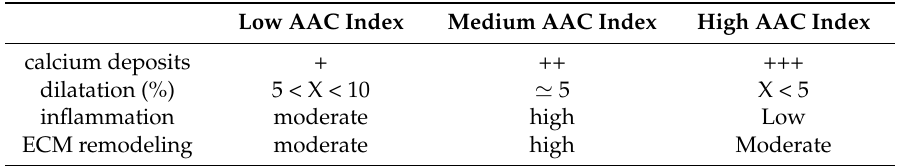
Table 2. Summary of obtained data. It shows the results obtained on AAA tissue in terms of calcium accumulation, dilatation, inflammation value, and matrix remodeling.